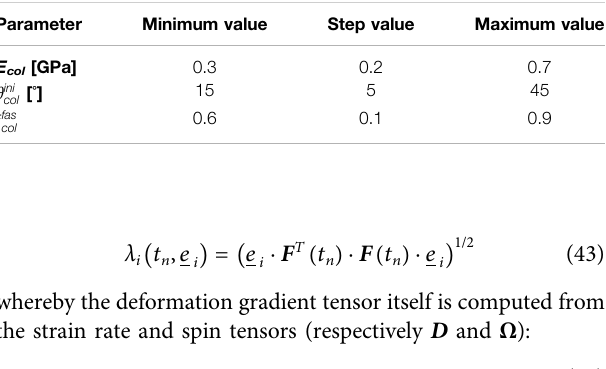
TABLE 2 | Parameters studied in the sensitivity analysis.